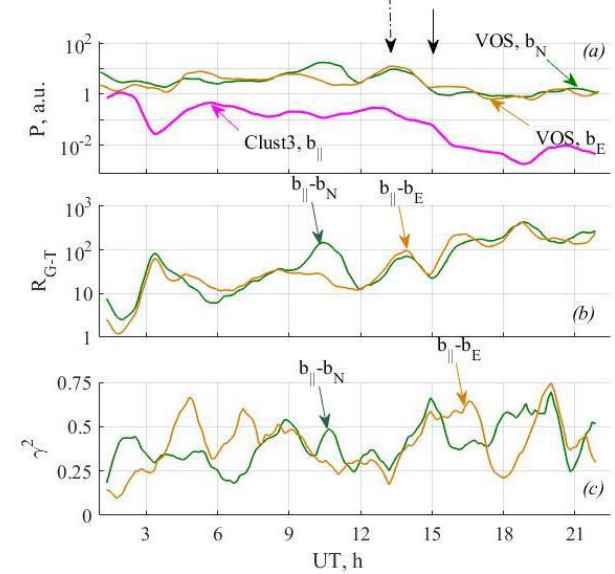
Figure 10. Time variations in (a) spectral power, (b) the ground to tail spectral ratio R G − T , and the average (c) spectral coherence in the 1.2–1.9mHz frequency band for the b || components at Cluster 3 and both horizontal components at VOS. Time instants with a de- crease in the spectral power of IMF fluctuations and pulsations in b || at Cluster are marked with dot-dashed and solid arrows respec-